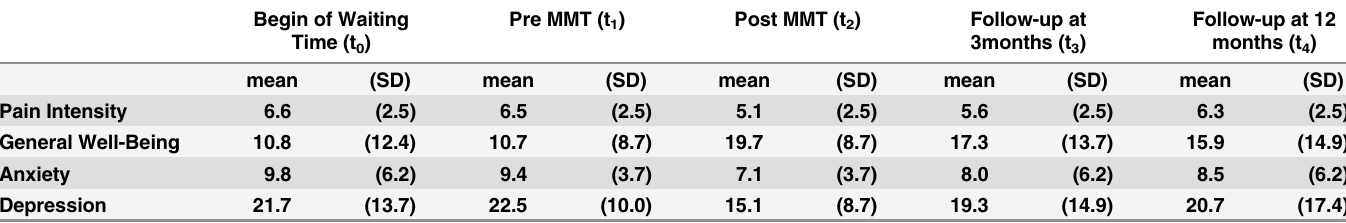
Table 3. Time course of pain intensity (NRS), general well-being (MFHW), anxiety (HADS) and depression (ADS). Begin of Waiting Time (t 0 )